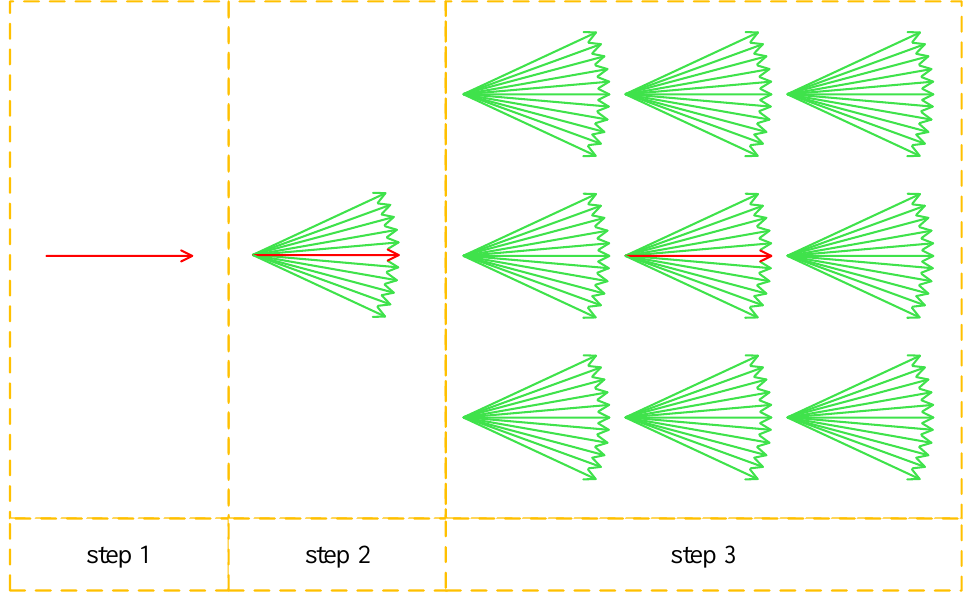
Figure 4. Correlative particle sampling.